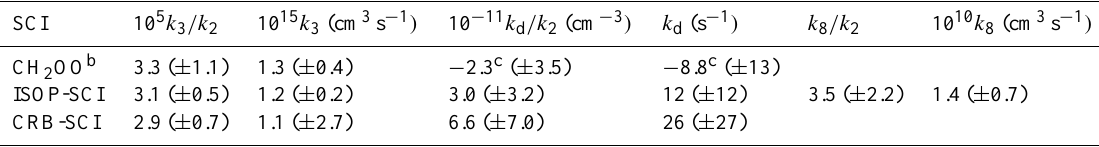
Uncertainty ranges ( ± 2 σ , parentheses) indicate combined precision and systematic measurement error components. a Scaled to an absolute value using k